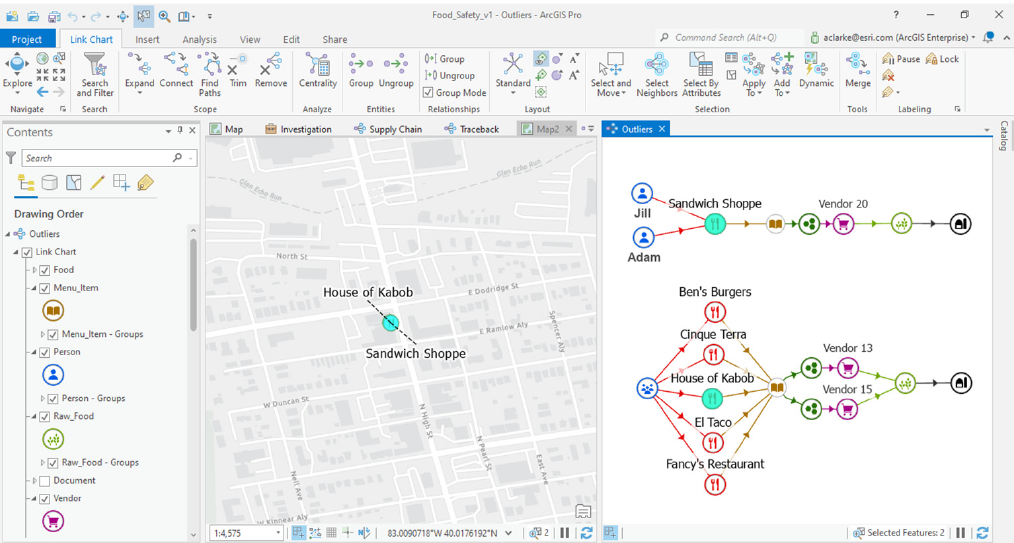
Figure 2. Using GIS and KGs to trace disease pathways for an outbreak of Cyclosporiasis.